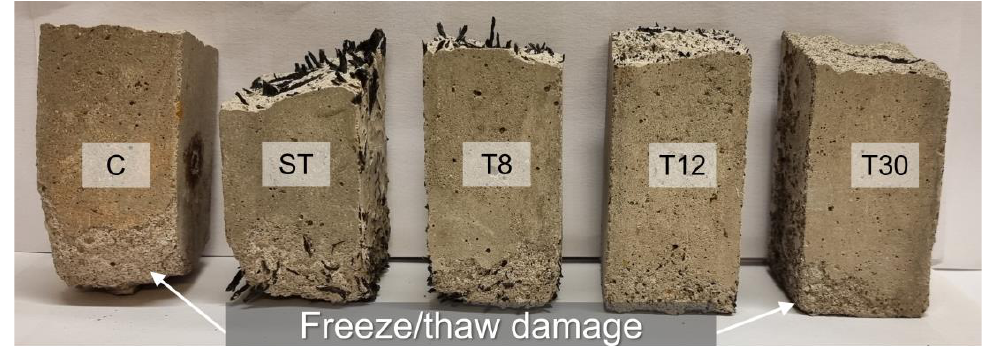
Figure 5. Visual inspection of samples after exposure to freeze/thaw cycles.